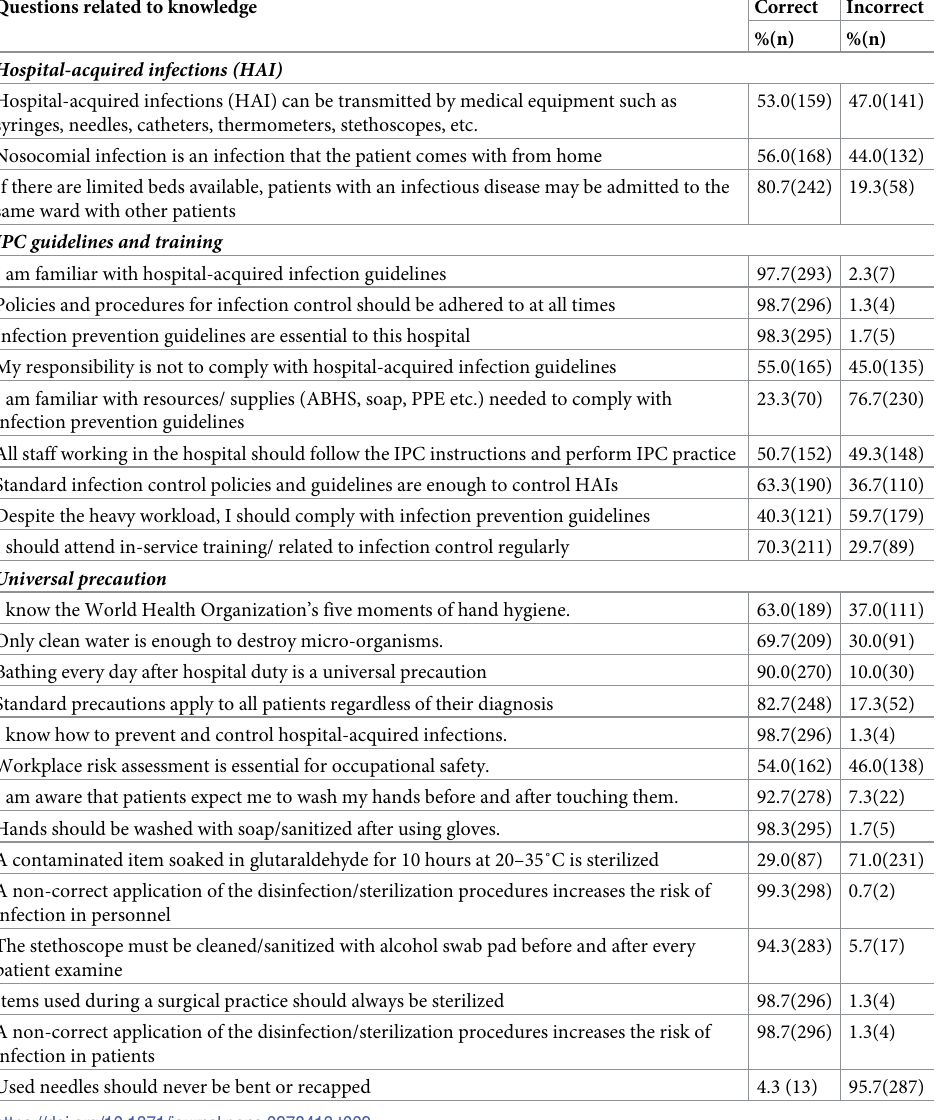
Table 2. Knowledge of the nurses regarding infection prevention and control, universal precautions, disinfection, sterilization (N = 300). Questions related to